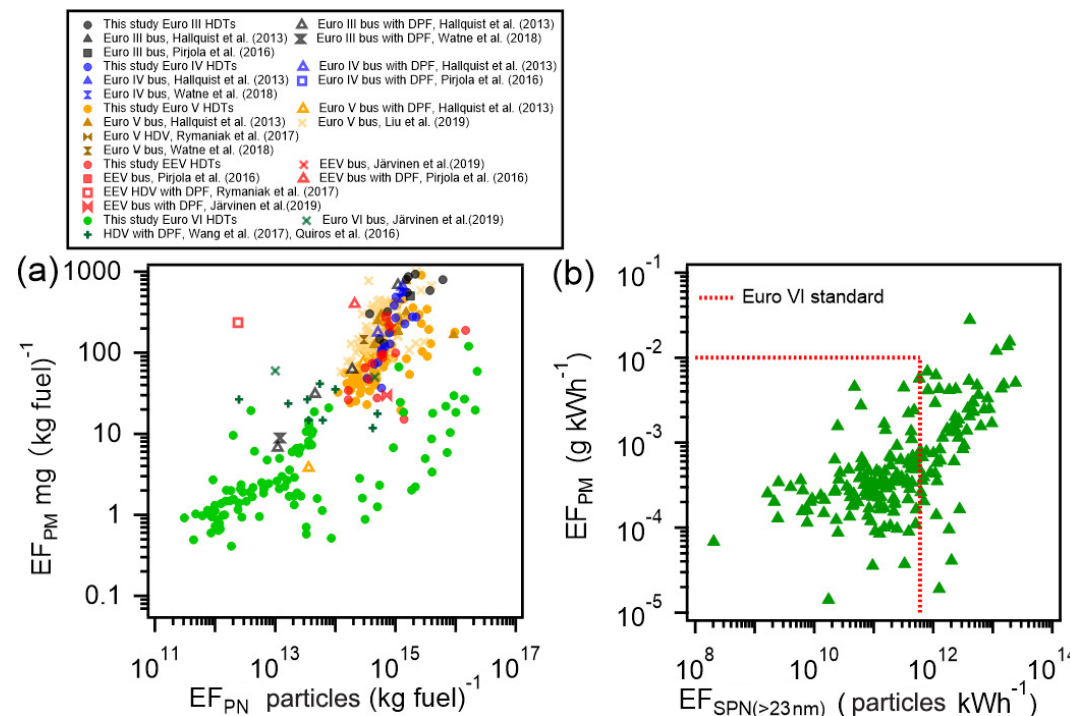
Figure 3. (a) EF PM and EF PN of individual HDTs in this study and previous studies and (b) the relationship between EF PM and EF SPN of Euro VI HDTs. Dashed red lines represent Euro emission standards (horizontal: PM emission standard; vertical: SPN emission standard). HDTs with either EF PM or EF PN values lower than the detection limits of the instruments were removed in (a) for illustration purposes. Note that the comparison with the emission standard is only indicative as they are based on test cycle